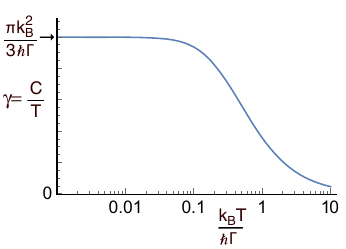
Fig. 4 Heat capacity of a single spin- fl uctuation mode. The temperature dependence of γ = C / T for a single spin- fl uctuation mode with a temperature- independent relaxation rate Γ calculated from